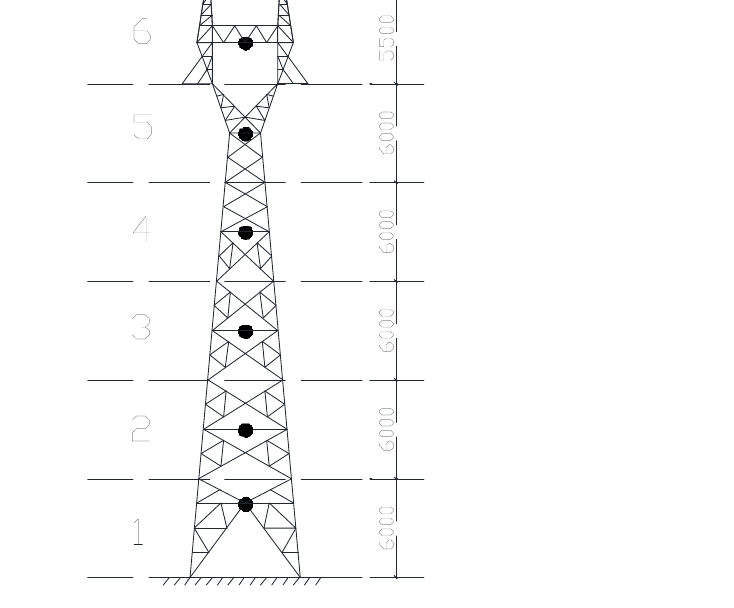
Figure 18. Schematic diagram of the simulated wind loads in sections (unit: mm).